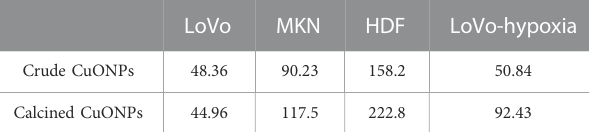
TABLE 3 Calculated IC 50 (µg/ml) values of crude and calcined CuONPs on different cell